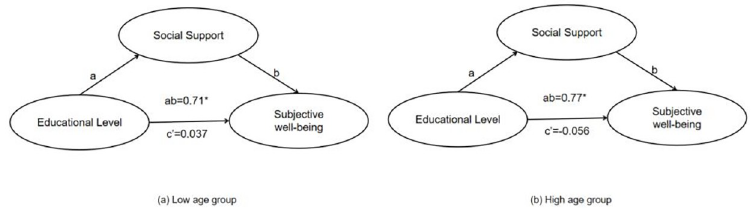
Fig 3. The relationship between educational level, social support and SWB in different age groups.